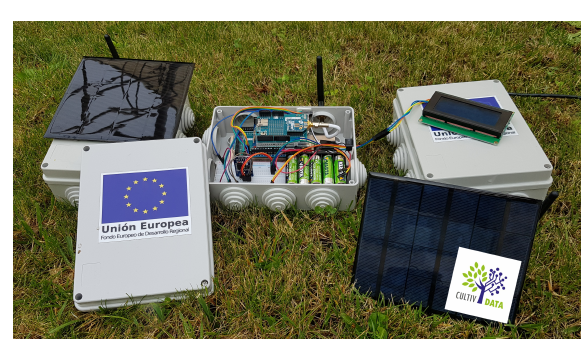
Figure 6. First prototype of a sensorization device.